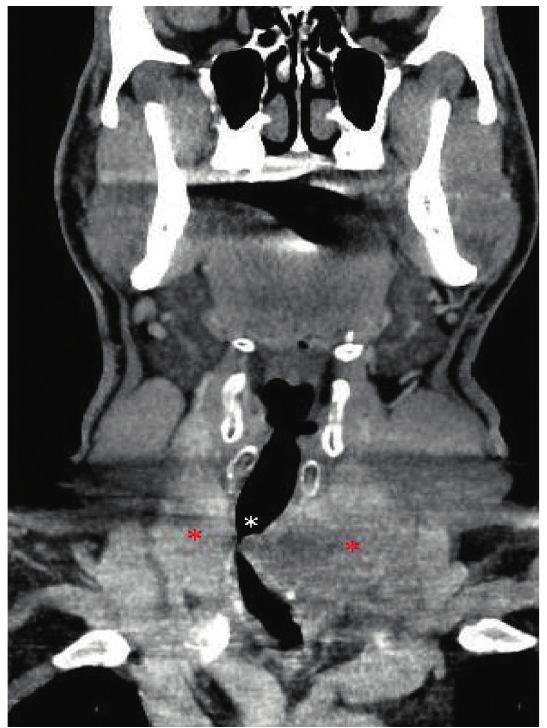
Figure 3: Enhanced coronal computed tomography image dem- onstrating severe narrowing of the trachea (white asterisk) by bilateral thyroid lobe tumor (red asterisks).